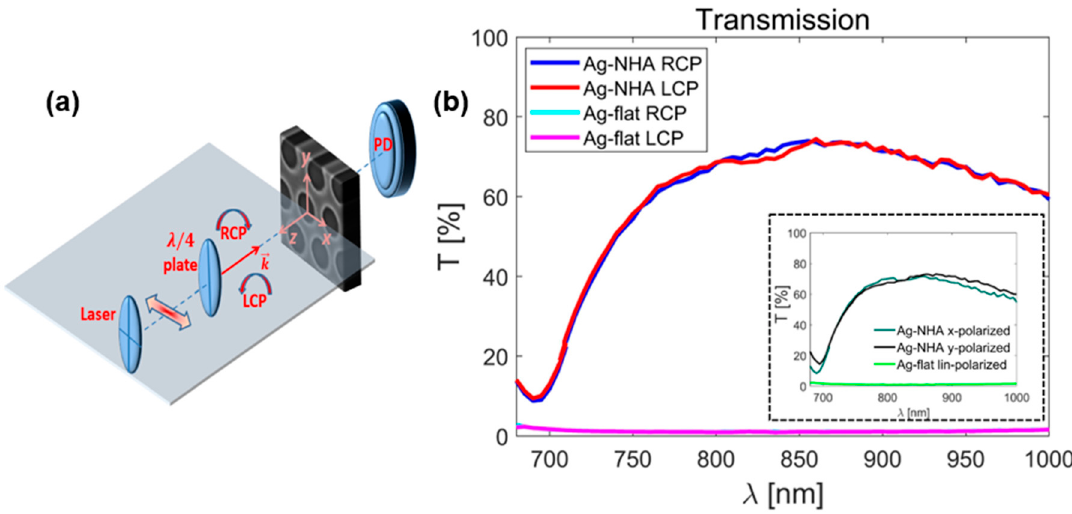
Figure 2. ( a ) Sketch of the experimental set-up; ( b ) Zero-order transmission spectra of the RCP and LCP light, exciting Ag-NHA and Ag-flat; inset: zero-order transmission spectra of linearly polarized light in x- and y-direction, exciting Ag-NHA and Ag-flat.